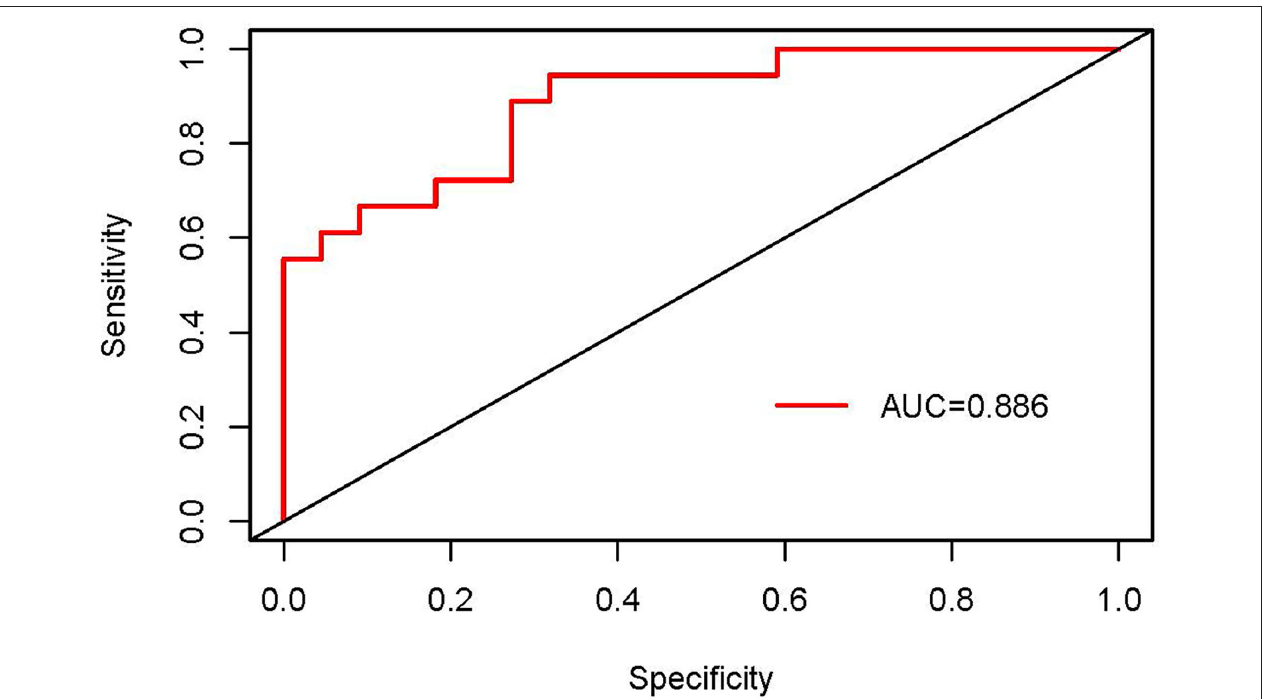
FIGURE 5 | The receiver operating characteristic (ROC) curves of the nomogram in the validation